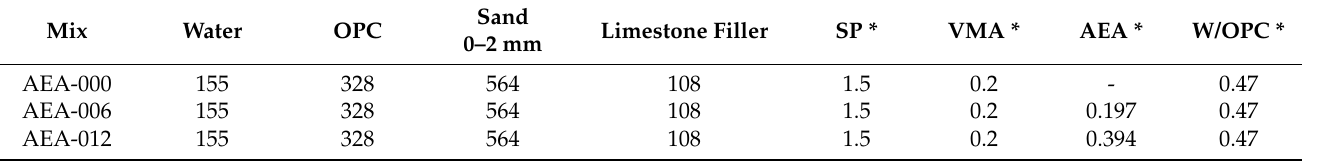
Table 1. Concrete mix proportions for Mix AEA-000, Mix AEA-006, and AEA-012 (amounts expressed in grams per 1000 g of dry